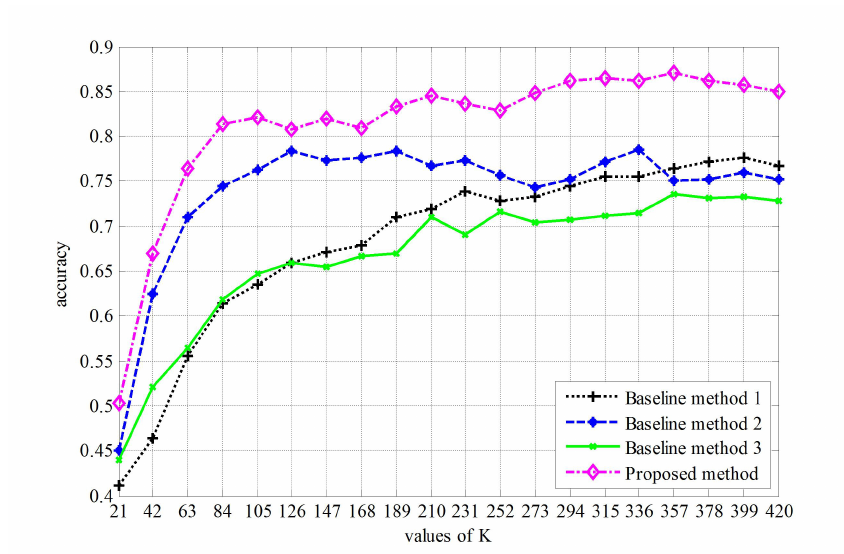
Figure 9. Comparison of different methods.